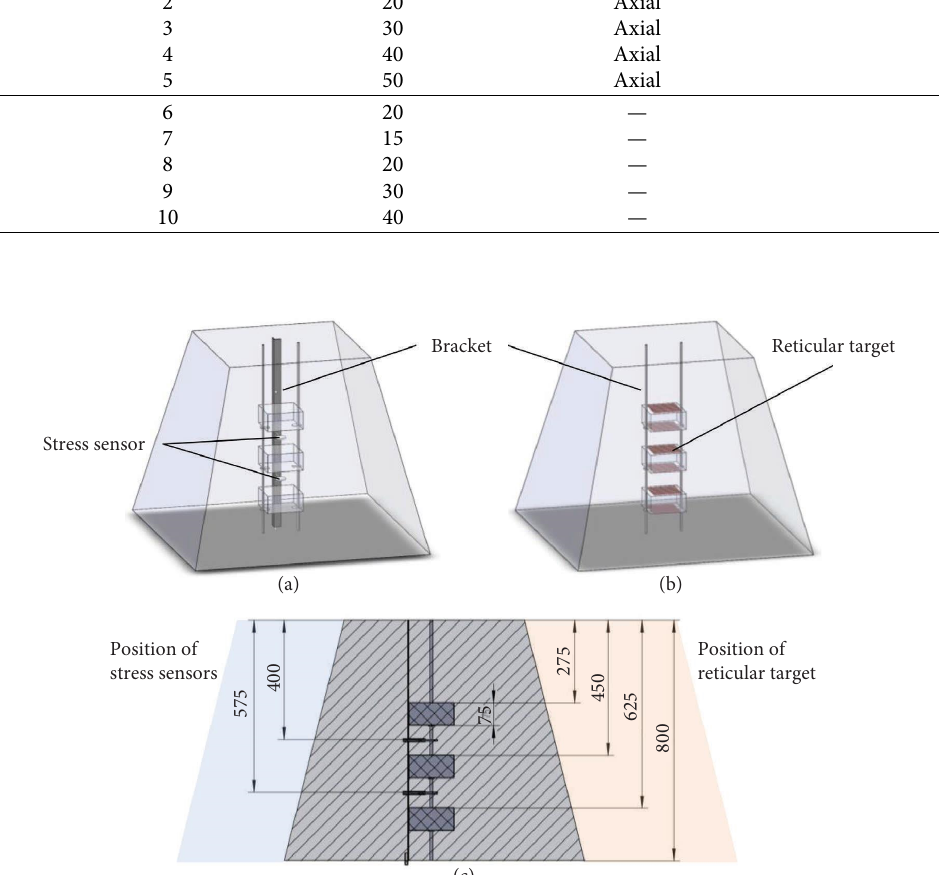
Figure 7: Positions of the sensors. (a) Conditions 2 ∼ 5. (b) Conditions 7 ∼ 10. (c) Position dimensions of the sensors.